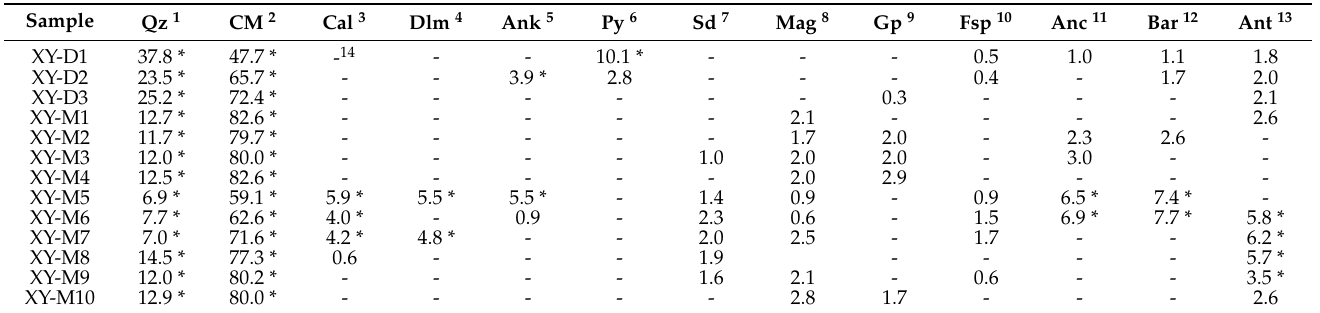
Table 2. Mineral compositions of the No. 9 coal and related roof samples from the Xinyuan mine, determined by XRD (%).